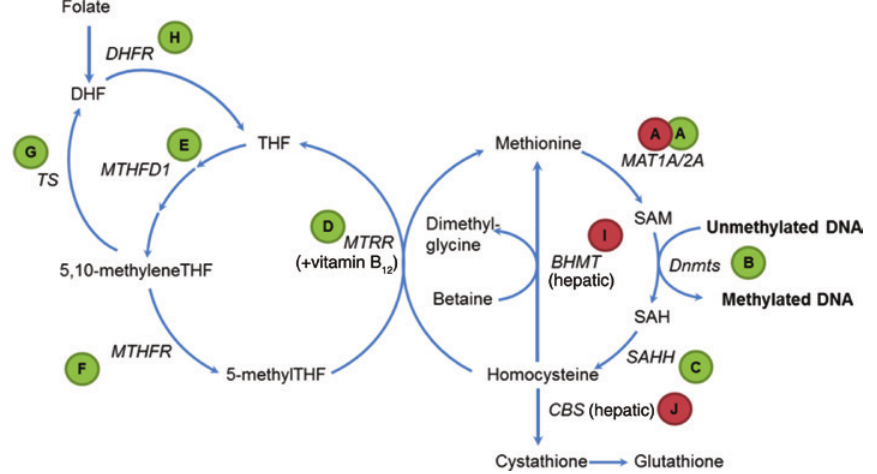
Figure 1: Overview of one-carbon